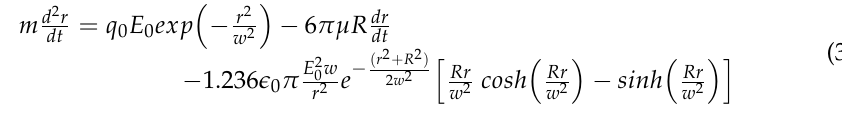
Figure 7. ( a ) The refractive index behavior in relation to cell radius for the control (red), 2 h-treated (green), and 24 h-treated (blue) group. ( b ) Reduced data for the refractive index vs. R using Oigin data reduction method by grouping and then fitted linearly for control (red), 2 h-treated (green), and 24 h-treated (blue)